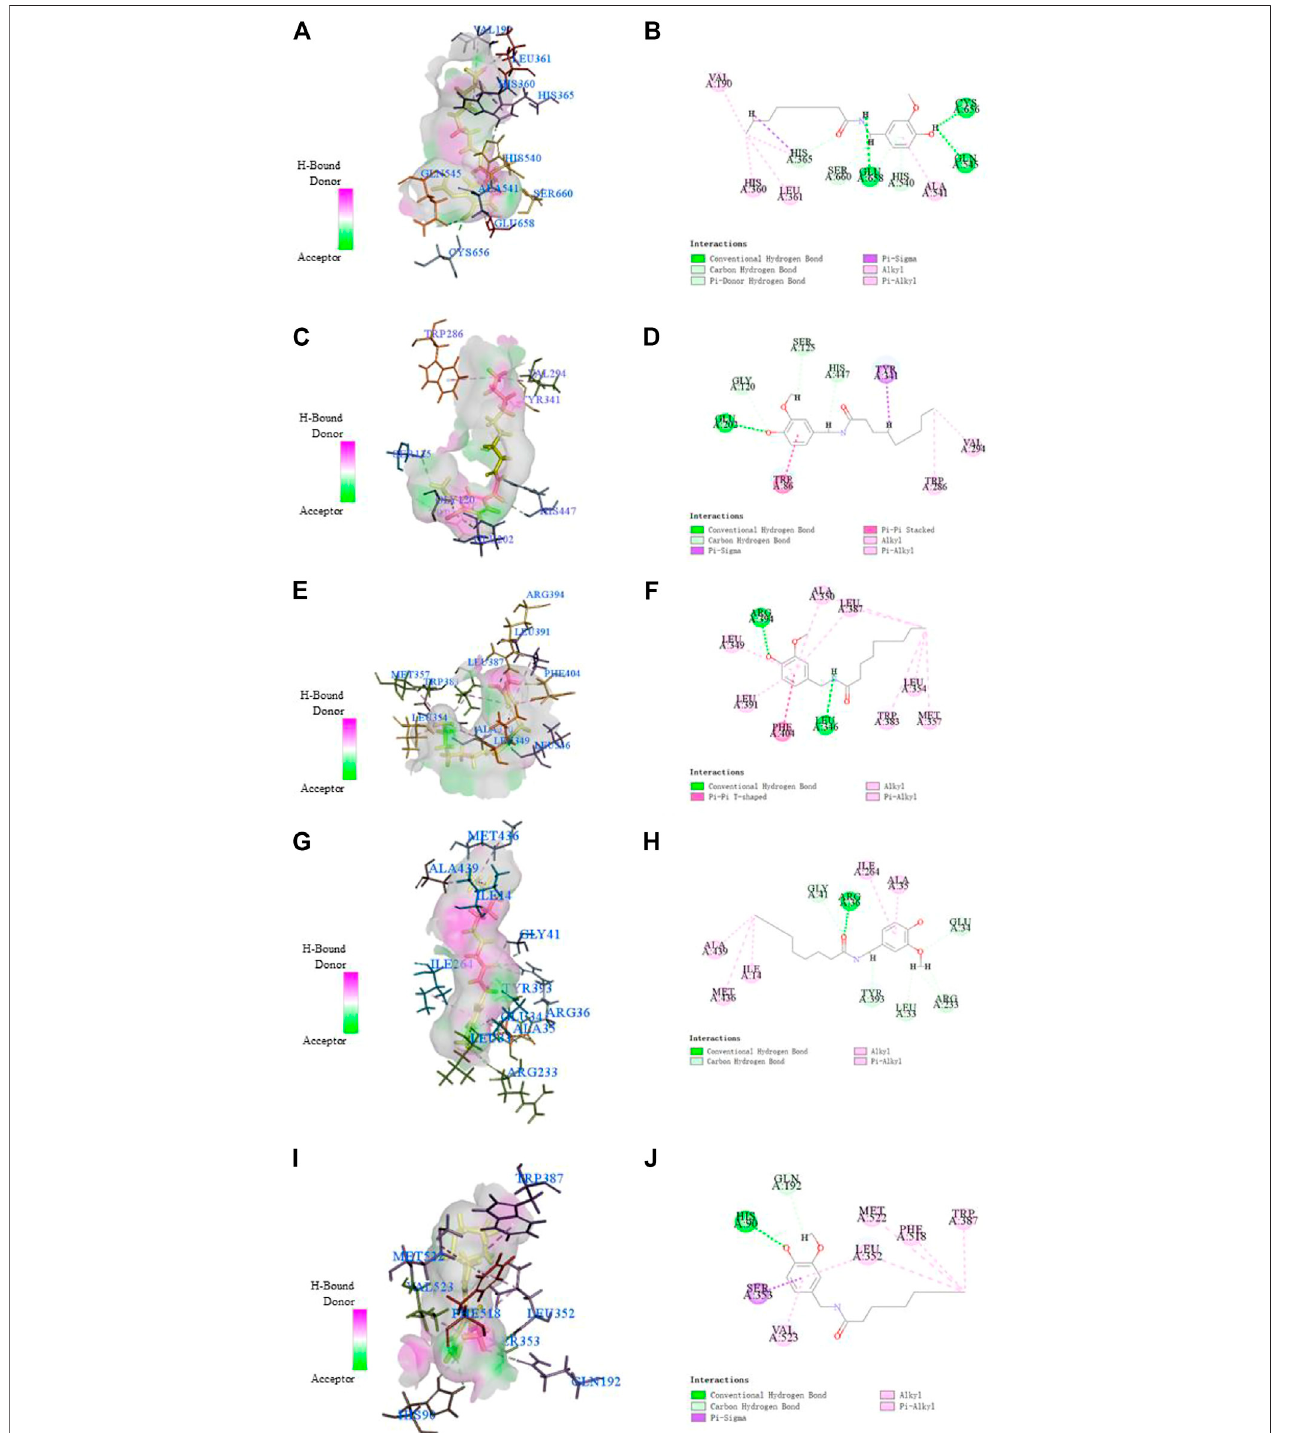
FIGURE15| Thereceptor-ligandinteractionofNonivamidewiththeactivesiteofALOX12 (A,B) ,ACHE (C,D) ,ESR1 (E,F) ,MAOB (G,H) ,PTGS2 (I,J) .Theligand was highlighted in yellow in 3D model diagrams.